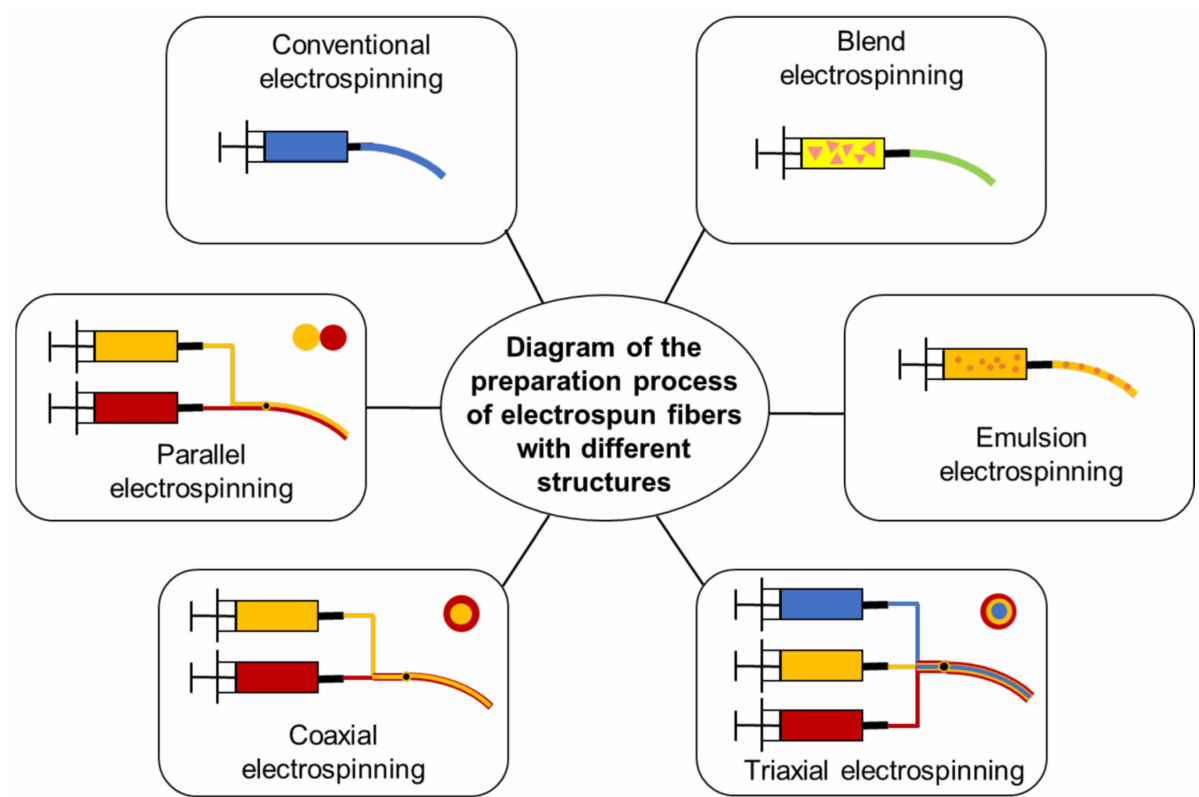
Figure 5. Schematic diagram of the process of electrospun fibers with different structures prepared under corresponding